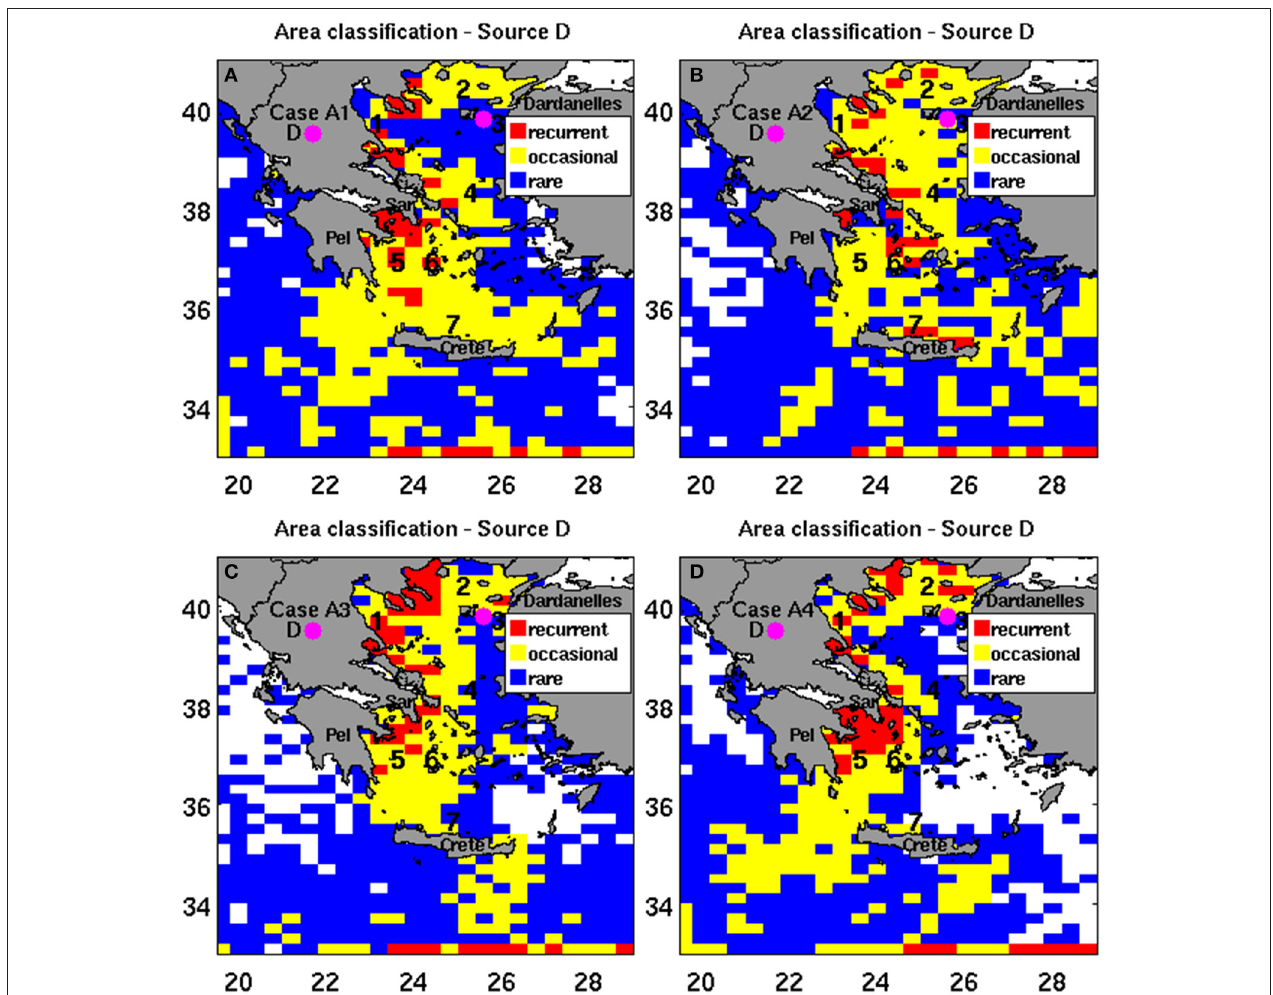
FIGURE 8 | Area classification maps of floating litter particles originated from region D (Dardanelles strait) in Cases (A) A1, (B) A2, (C) A3, and (D) A4. Magenta dot point indicates the source region